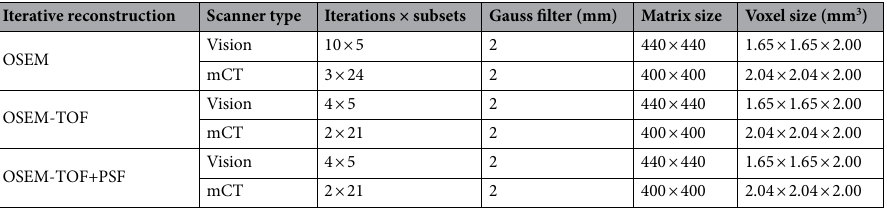
Table 2. Overview of the image reconstruction parameters for both PET